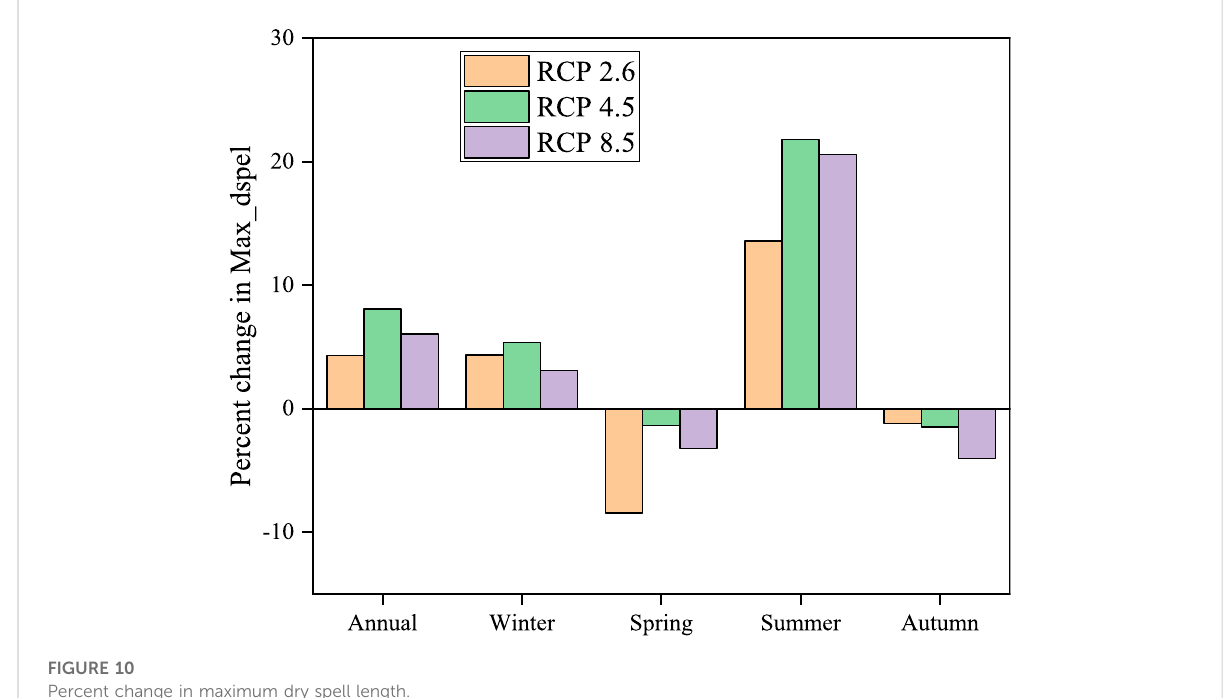
FIGURE 10 Percent change in maximum dry spell